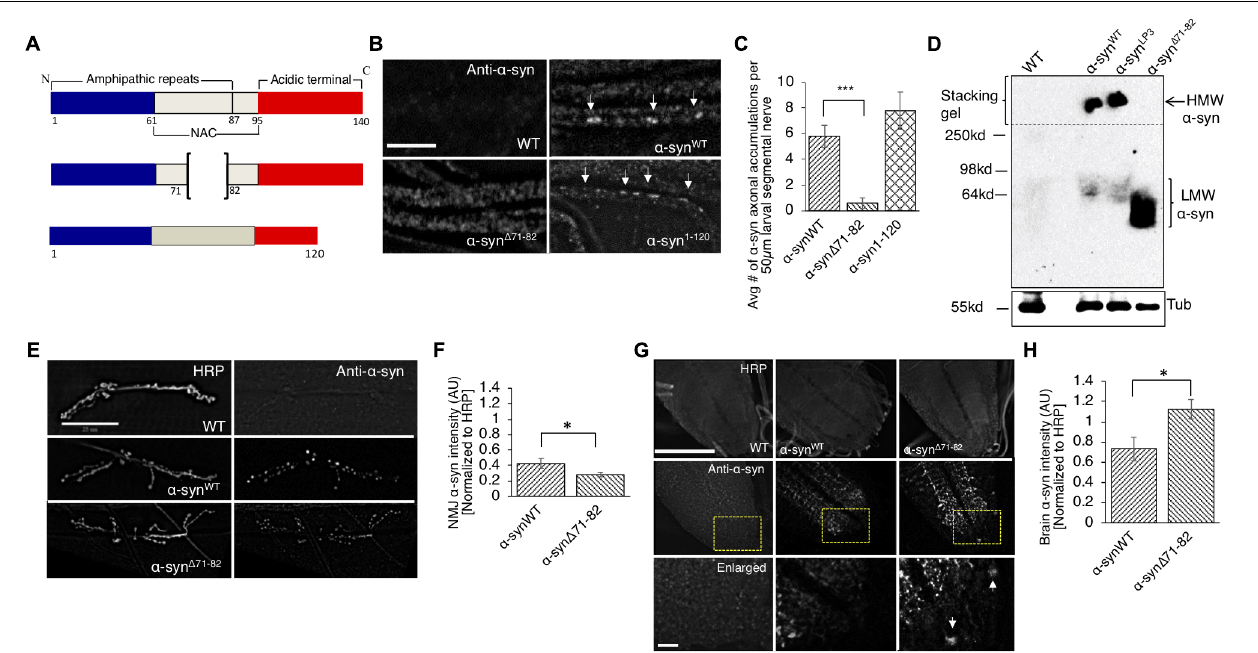
FIGURE 4 | The NAC region is required for the axonal transport of α -syn to synapses. (A) Schematic representation of full-length α -syn (140 amino acids), α -syn with a deletion of region 71-82 in the non-amyloidal component (NAC, α -syn (cid:49) 71 − 82 ), and α -syn lacking the C-terminal region (1-120, α -syn 1 − 120 ) (not drawn to scale). (B) α -syn antibody staining within α -syn (cid:49) 71 − 82 expressing larval segmental nerves appear mostly diffused while α -syn WT or α -syn 1 − 120 larval nerves show axonal accumulations (arrow, bar = 25 µ m). (C) Quantification of the average number of α -syn accumulations within α -syn (cid:49) 71 − 82 larval segmental nerves indicates significant decreases as compared to α -syn WT larval nerves ( p < 0.001), while the extent of α -syn accumulations in α -syn 1 − 120 larval segmental nerves is similar to α -syn WT ( n = 7). (D) Native non-denaturing gel electrophoresis and Western blot analysis indicate that α -syn (cid:49) 71 − 82 does not form higher molecular weight HMW) α -syn species in flies. Note a low molecular weight (LMW) smear around 60–64 kDa. Tubulin is used as a loading control. (E) α -syn and HRP staining in WT, α -syn WT , and α -syn (cid:49) 71 − 82 larval NMJs at segment A2 of muscle 6/7 (bar = 25 µ m). (F) Quantitative analysis indicates a significant decrease in α -syn intensity (normalized to HRP) at α -syn (cid:49) 71 − 82 larval NMJs compared to α -syn WT larval NMJs ( p < 0.05, n = 10). (G) α -Syn and HRP staining within WT, α -syn WT , and α -syn (cid:49) 71 − 82 larval brains. Bottom panel represents an enlarge portion of the brain (inset). Note the accumulation of α -syn within the cell body within α -syn (cid:49) 71 − 82 expressing larvae (arrow). (H) Quantification of α -syn intensity (normalized to HRP) within the brain of α -syn (cid:49) 71 − 82 larvae indicates a significant increase in α -syn compared to α -syn WT larval brains ( p < 0.05, n = 5). The quantitative analysis represents the mean ± SEM. ∗ p < 0.05, ∗∗∗ p < 0.001. AU = arbitrary